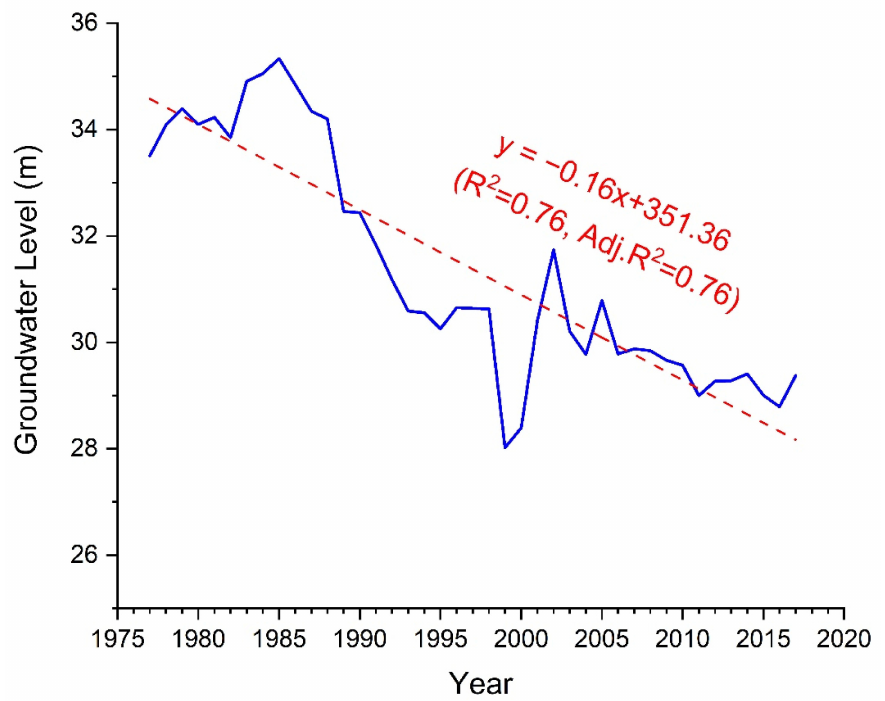
Figure 6. Results of the linear regression of the groundwater level in the Gnangara